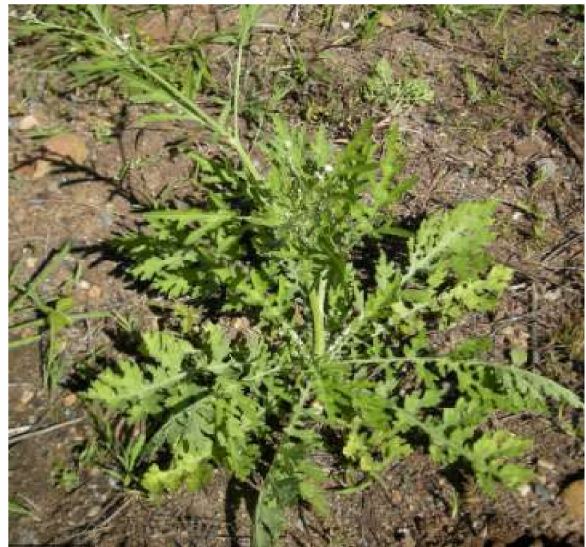
Figure 3. The rosette stage of Parthenium.